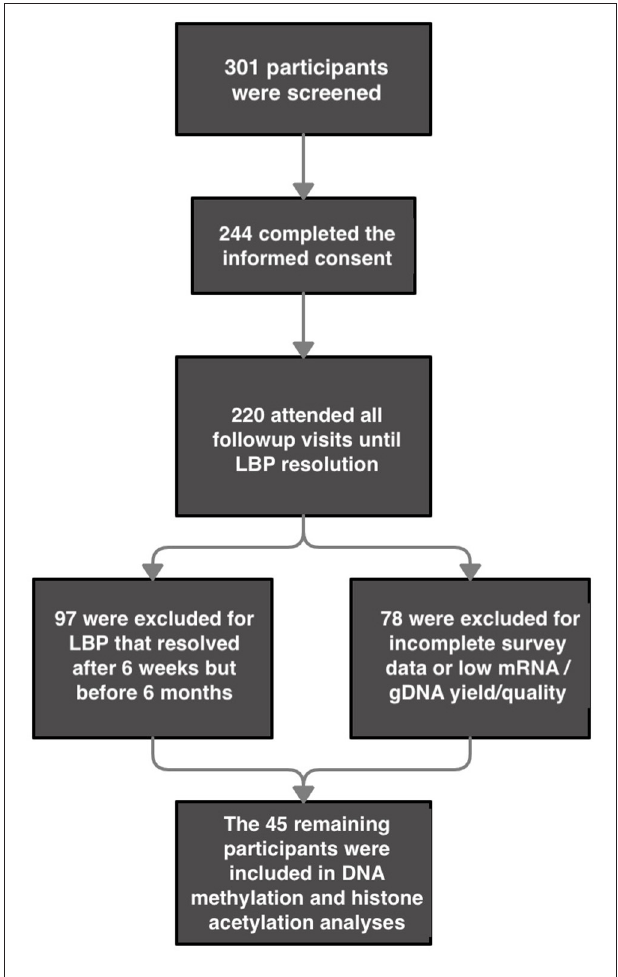
FIGURE 1 | Flow Chart for participant inclusion. *2 participants were excluded from gene expression analyses for having undetermined values in their housekeeping genes but were included for all other analyses for which their data sets were